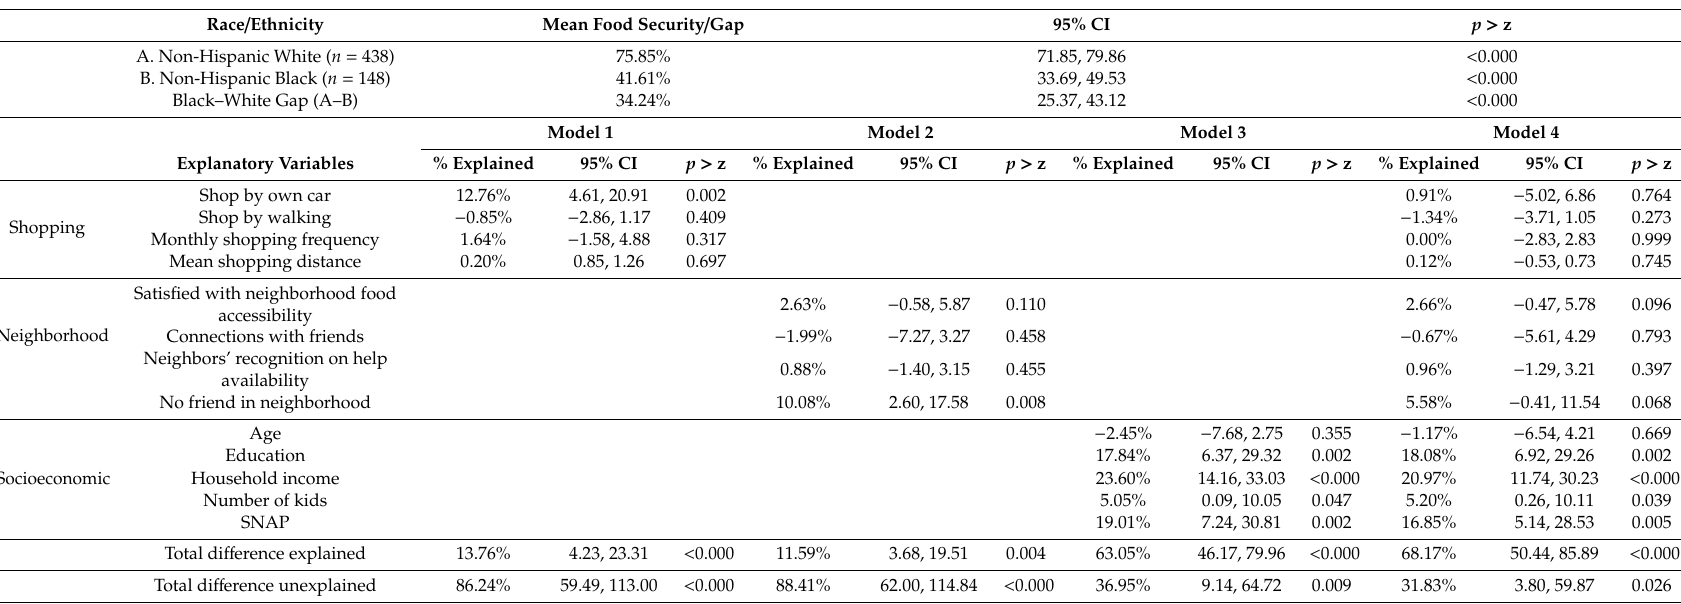
Table 2. Explained and unexplained portions of food security gap between Blacks and